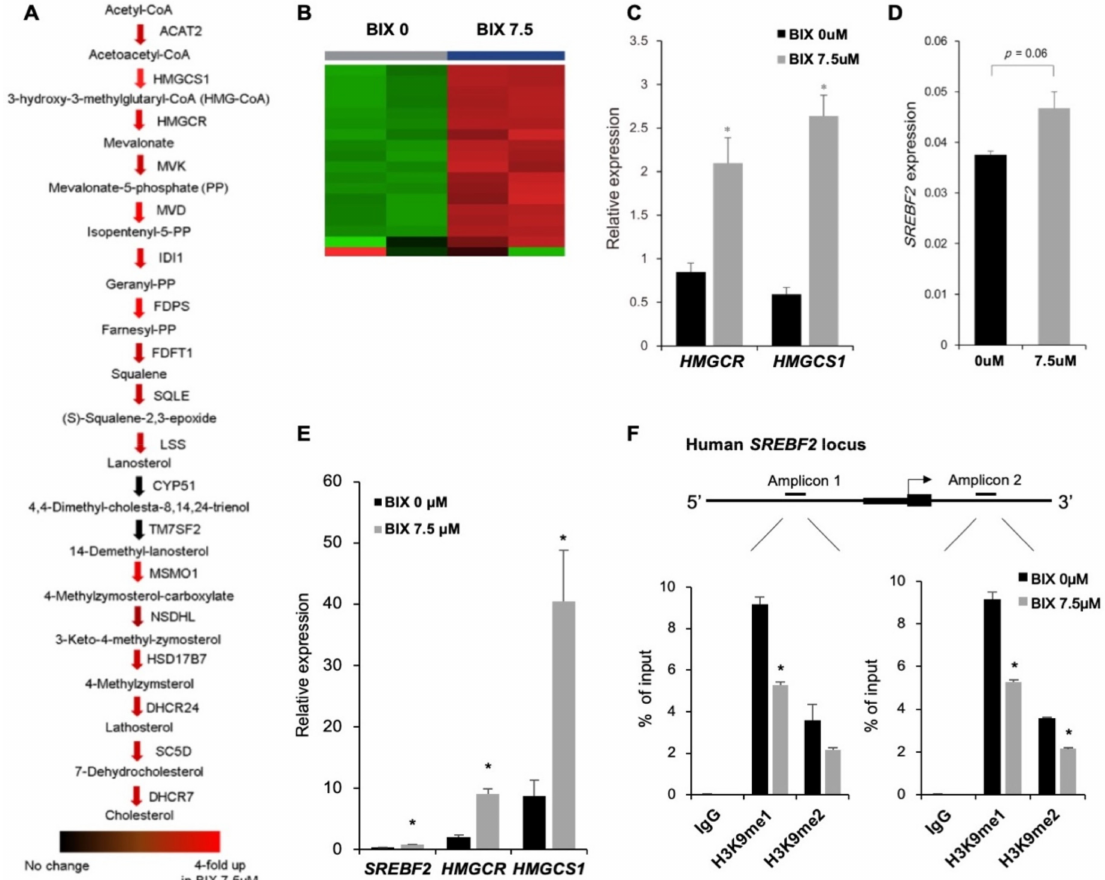
Figure 4. Induction of the cholesterol biosynthesis pathway by direct regulation of BIX in the SREBF2 locus. ( A ) Expressions of genes, annotated as cholesterol biosynthesis, were presented with colored arrows, based on RNA sequencing data. A range of redness indicates a level of upregulation in the 7.5 µ M BIX-treated group, as compared to non-treated group. ( B ) The expression pattern of cholesterol synthesis-related genes shown in heatmap according to RNA sequencing of H1299 with non-treatment or 7.5 µ M of BIX treatment. ( C ) Expression of genes in cholesterol biosynthesis was validated by qRT-PCR of HMGCR and HMGCS1 . ( D ) Expression of SREPF2 was validated by qRT-PCR. ( E ) Expression of cholesterol synthesis-related genes in BIX-treated A549 was analyzed. ( F ) Results from chromatin immunoprecipitation using antibodies against histone H3 lysine 9 mono-methylation (H3K9me1) and histone H3 lysine 9 di-methylation (H3K9me2) were presented as % enrichment of input at the promoter of SREBF2 . IgG is a negative control for immunoprecipitation. * p < 0.05 against the 0 µ M BIX treatment